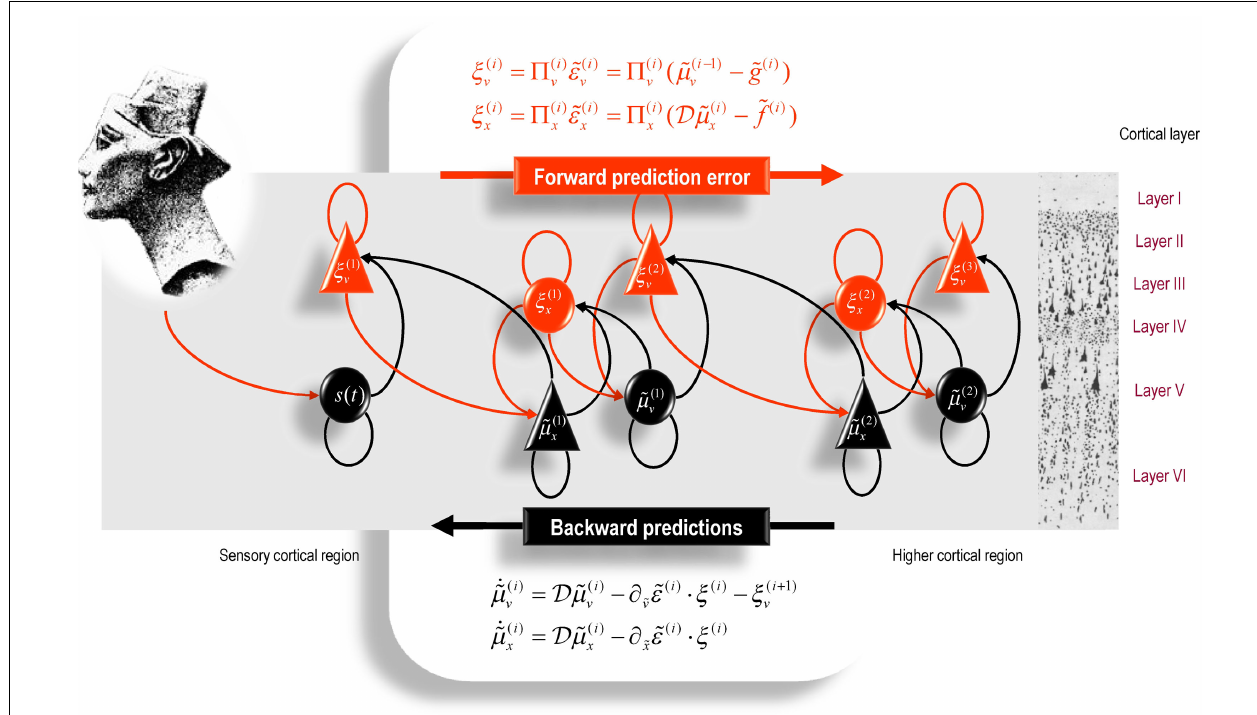
a generalized descent on free-energy under the hierarchical models described in the main text: see also (Friston, 2008). State units are in black and error units in red. Here, neuronal populations are deployed hierarchically within three cortical areas (or macro-columns).Within each area, the cells are shown in relation to cortical layers: supra-granular (I–III) granular (IV) and infra-granular (V–VI) layers. For simplicity, conditional expectations about control states had been absorbed into conditional expectations about hidden